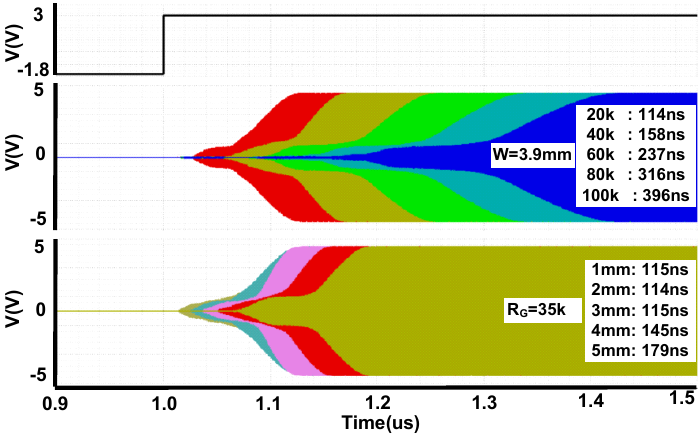
Figure 8. Switching time vs. different width and different gate